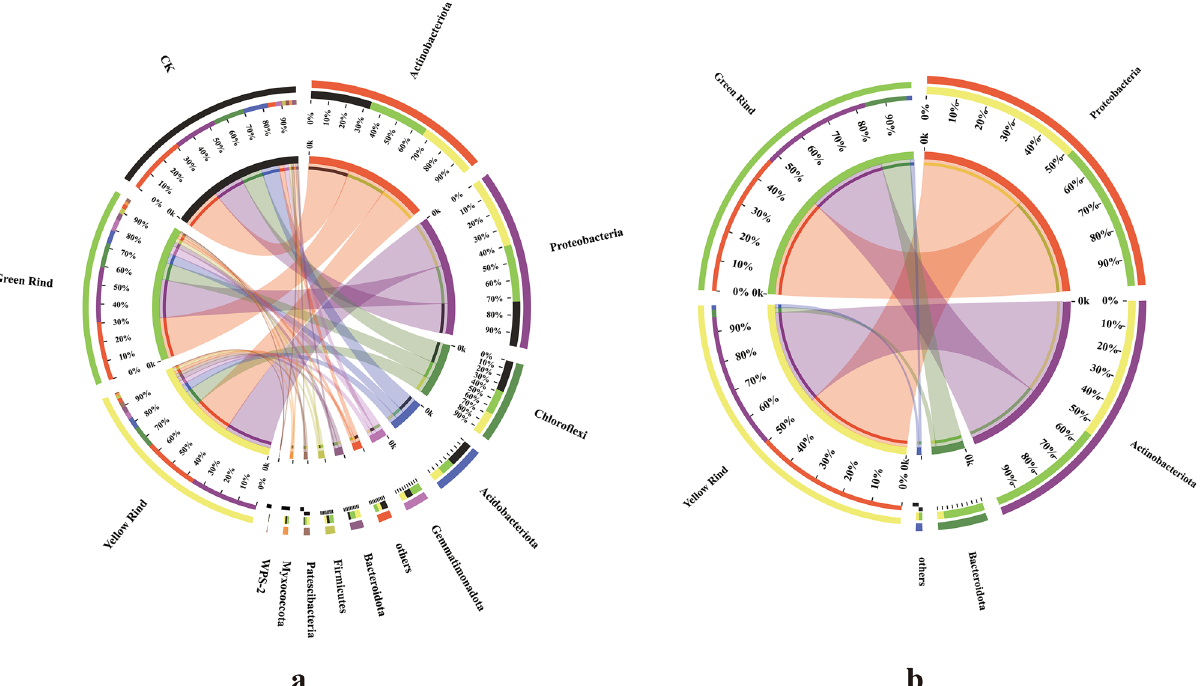
Figure 2. Distribution of soil dominant bacteria in rhizosphere ( a ) and endophytic ( b ) bacteria between yellow and green rinds of watermelons at phylum level. The data were visualized by Circos. The width of the bars from each phylum indicate the relative abundance of that phylum in the sample. The small half-circle (left half-circle) represents the species composition in the sample, the color of the outer colored band represents the grouping from which the species is derived, the color of the inner colored band represents the species, and the length represents the relative abundance of the species in the corresponding sample. The large half-circle (right half- circle) represents the proportional distribution of species in different samples at phylum level, the outer colored band represents the species, the inner the color of the colored band represents different groups, and the length represents the proportion of distribution of the sample in a particular